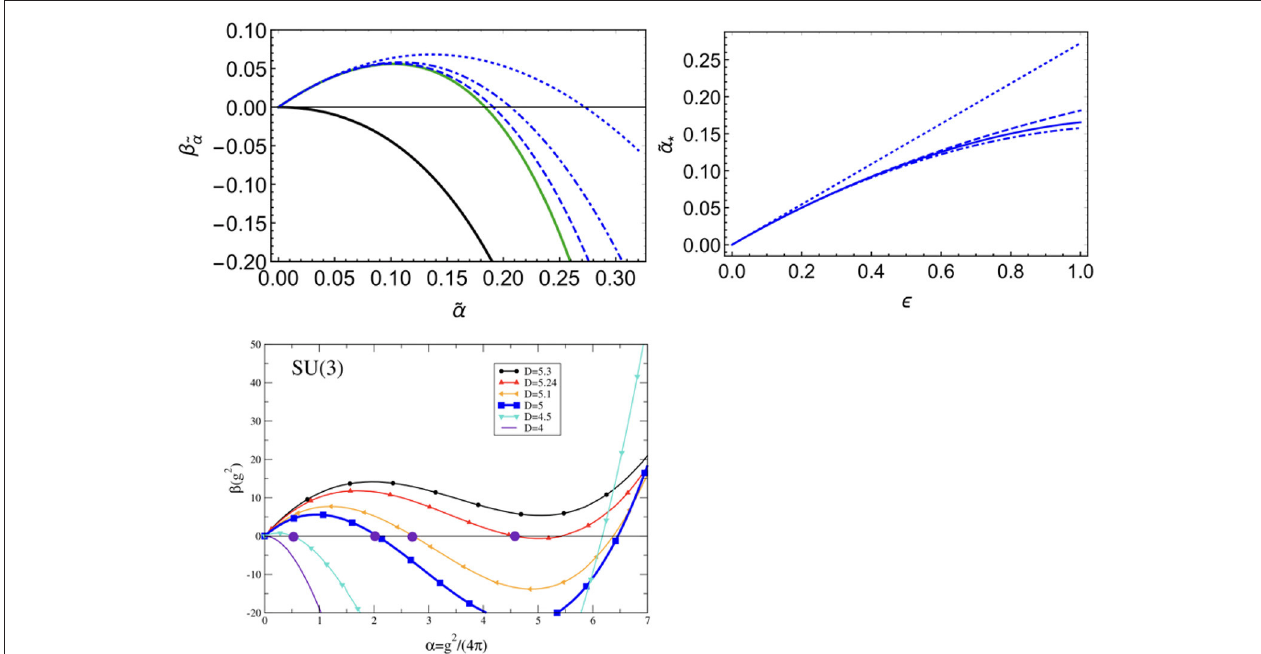
6 g 2 for ǫ α 0 (4 π ) 2 ˜ = = d crit , i.e., ǫ 0. Lower panel: Results from the FRG → →